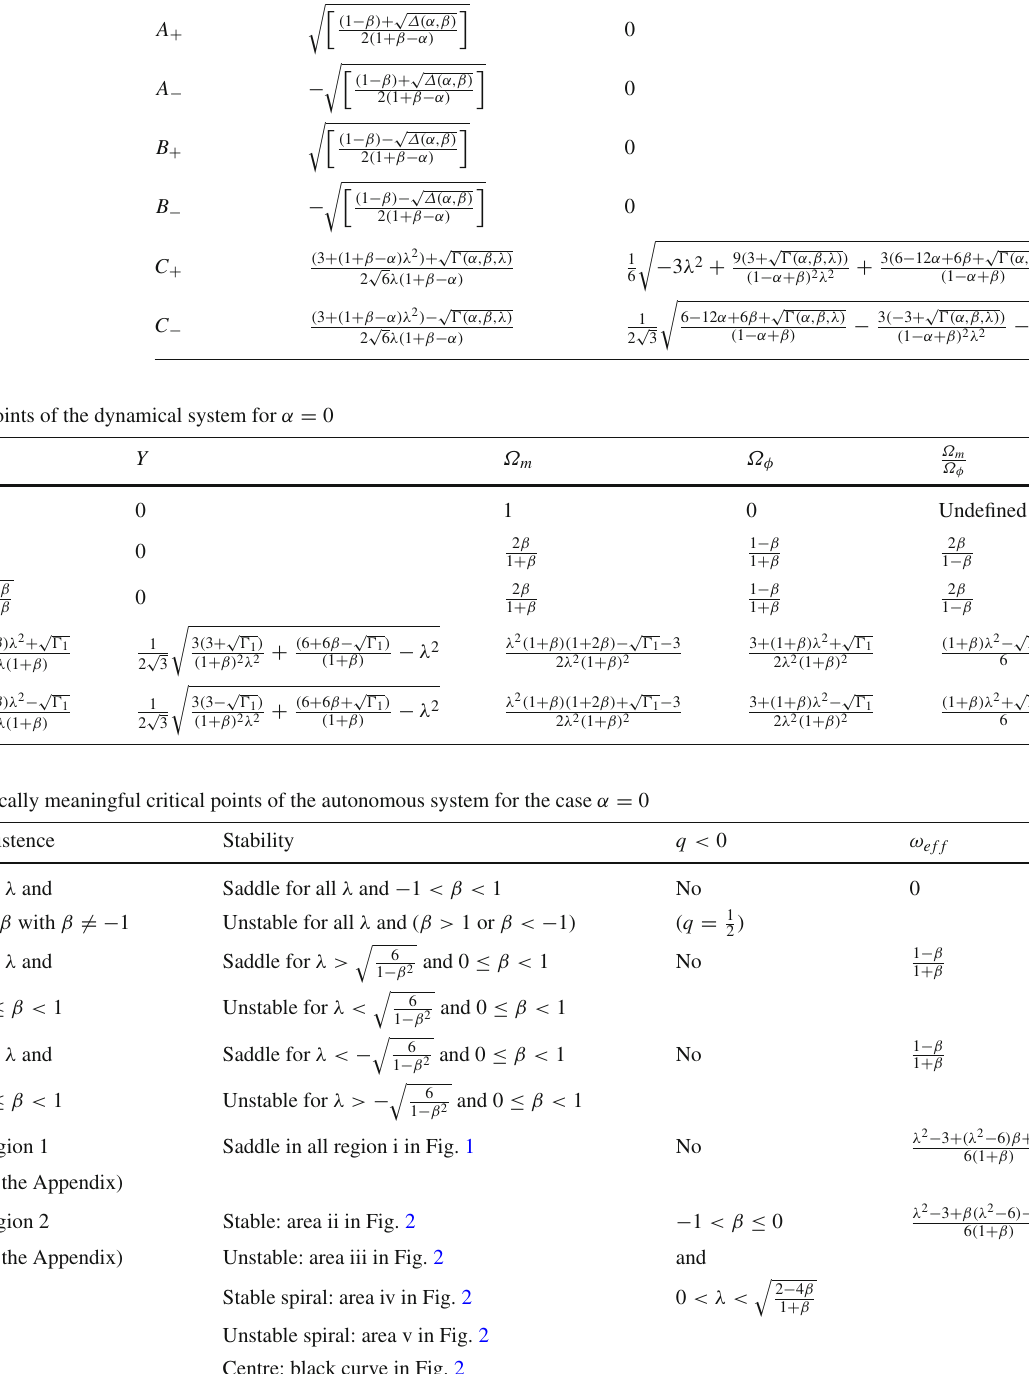
Unstable: area iii in Fig. 2 and Stable spiral: area iv in Fig. 2 Unstable spiral: area v in Fig. 2 Centre: black curve in Fig.